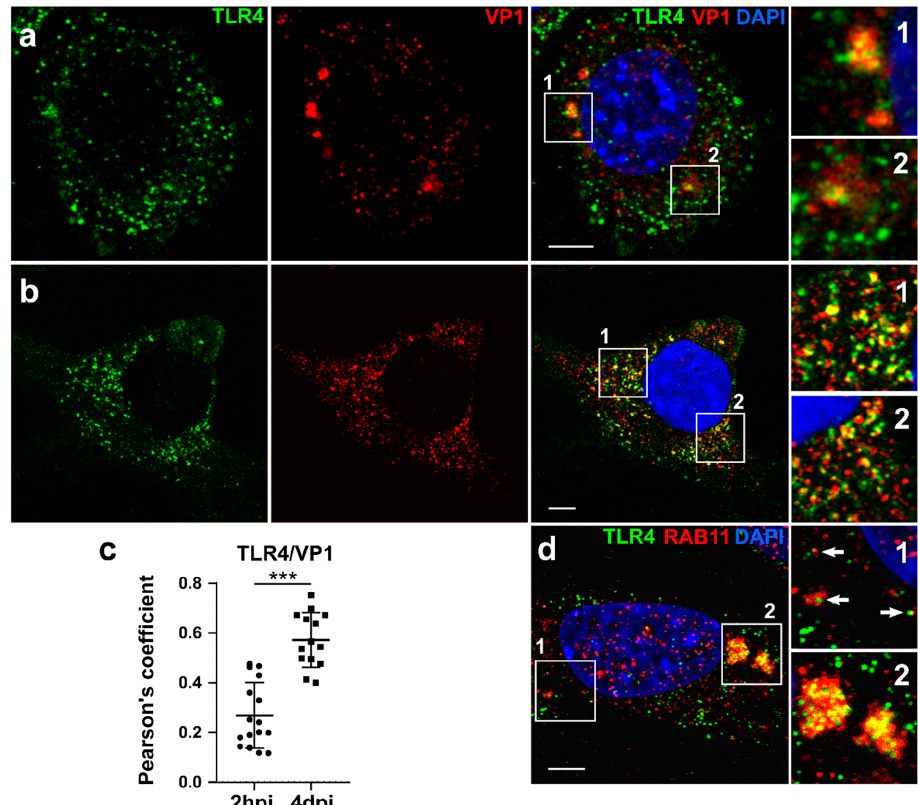
Figure 2. Colocalization of TLR4 and VP1 in MEFs. ( a ) Confocal section of MEFs infected with MPyV at a high virus input (MOI = 10). VP1 (red) and TLR4 (green) were stained by specific antibodies and DNA by DAPI. Colocalization of VP1 and TLR4 was analyzed 2 h post-infection. ( b ) Confocal section of MEFs infected with MPyV at a low virus input (MOI = 1). VP1 (red) and TLR4 (green) were stained by specific antibodies and DNA by DAPI. Colocalization of VP1 and TLR4 was analyzed 4 days post-infection. ( c ) Colocalization between intracellular virus and TLR4, expressed as Pearson ′ s coefficient. ( d ) Confocal section of MEFs infected with MPyV at a high virus input (MOI = 10). Rab11 (red) and TLR4 (green) were stained by specific antibodies, DNA by DAPI. Colocalization of Rab11 and TLR4 was analyzed 2 h post-infection. White squares show enlarged regions of VP1 and TLR4 or TLR4 and Rab11 colocalizations. Bars = 10 µm. *** p < 0.001; Kolmogorov–Smirnov test.